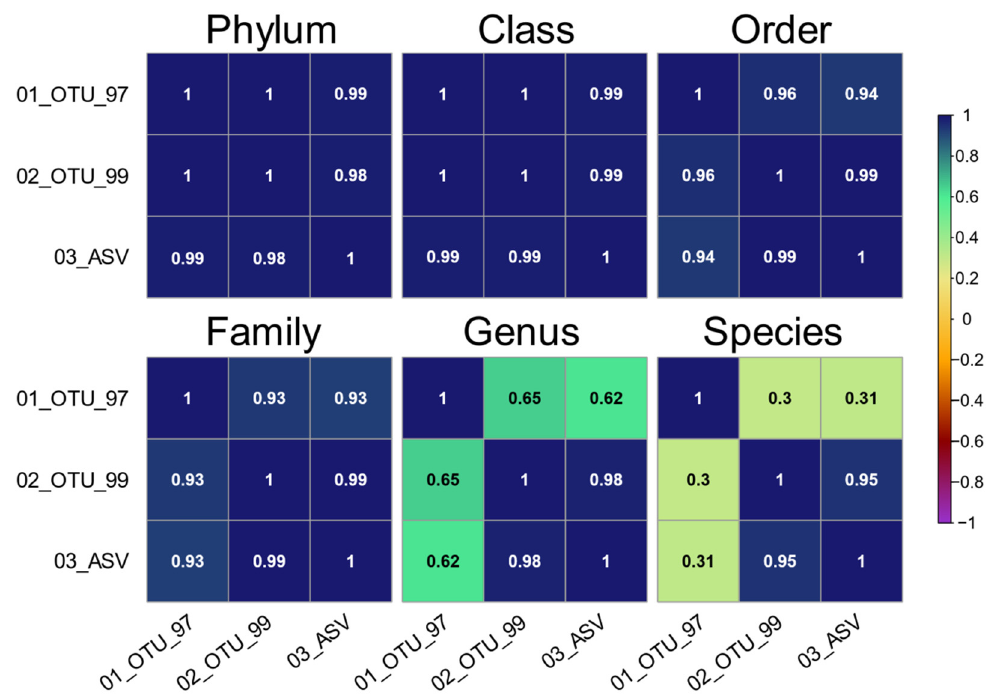
Figure 6. Spearman’s rank correlation ( ρ ) of the informative taxa distributions in all sets on multiple taxonomic levels. Only taxa with a valid unambiguous terminal taxonomic node are included. The upper or lower sections of symmetric matrices are presented per level to show all set permutations.